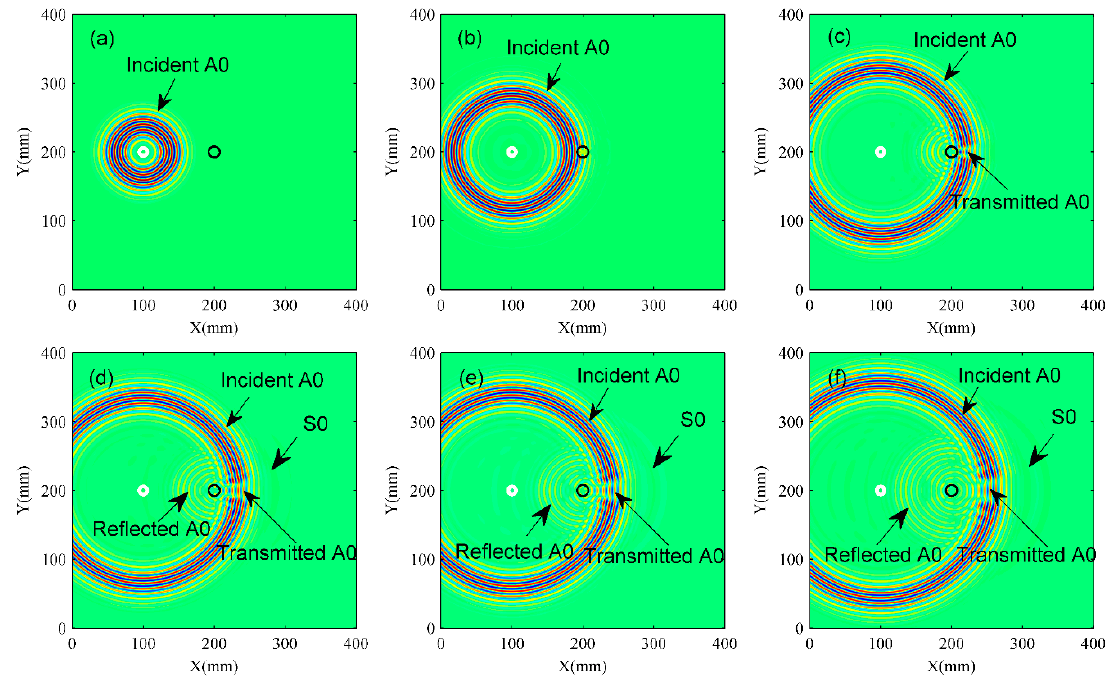
Figure 6. Snapshots of Lamb waves. ( a ) 74.18 us; ( b ) 91.31 us; ( c ) 105.89 us; ( d ) 111.60 us; ( e ) 114.14 us; ( f ) 120.48 us. The white circle denotes the incident point of the air-coupled transducer (ACT). The black circle represents the actual location of a defect.